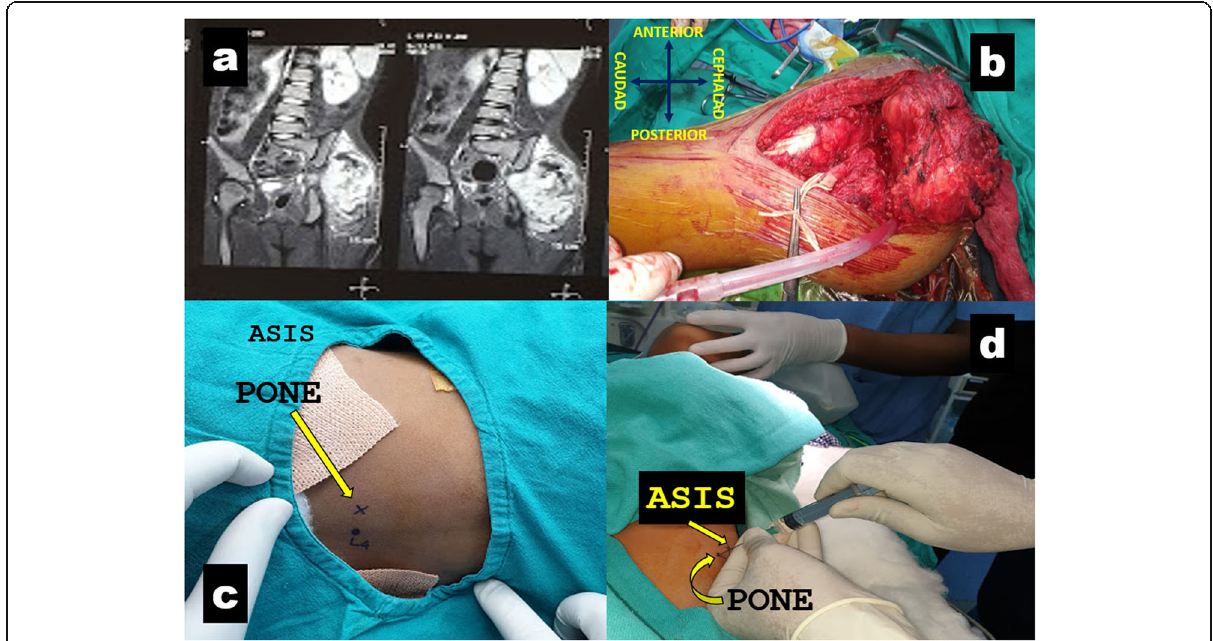
Fig. 1 a MRI scan of benign solitary gluteal neurofibroma. b Incision and excision of encapsulated tumor. c Anatomical landmark for LESPB. d Anatomical landmark for LFCN block. ASIS anterior superior iliac spine, PONE point of needle